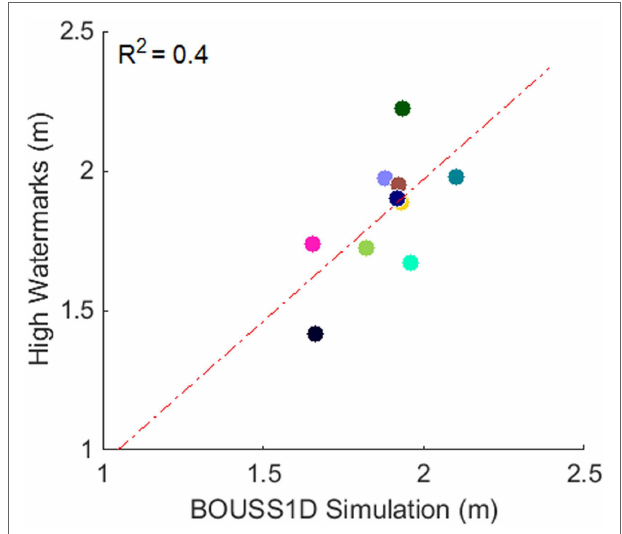
FIGURE 4 | Comparison of surveyed high watermark elevation above the ground and BOUSS1D simulated inundation for Ortley Beach. Note that the color of points corresponds to the colored markers in Figure 2A . Two watermarks—colored pink and black—are located beyond the extent of Figure 2A . [This figure is reproduced from Hatzikyriakou and Lin (2017).]